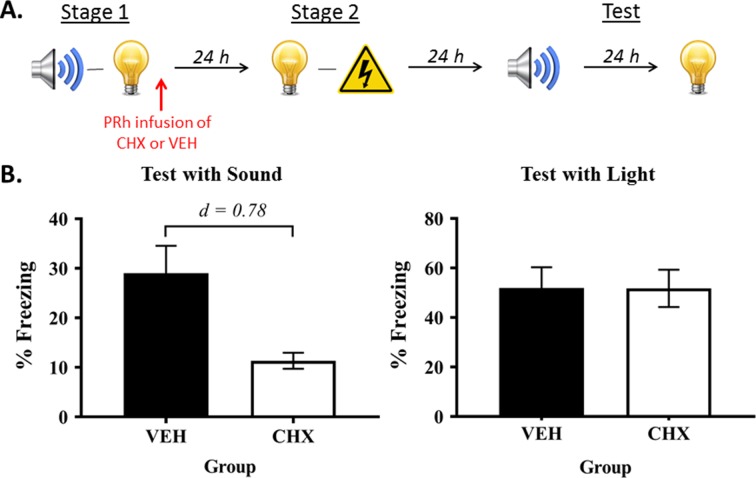
Protein synthesis in the PRh is required for consolidation of a sensory sound-light memory.(A) Schematic of the behavioral procedure for Experiment 2 (Group VEH, n = 8; and Group CHX, n = 10). The red arrow indicates infusions occurred immediately after stage 1 training. (B) Percentage freezing to the preconditioned sound (left panel) and to the conditioned light (right panel), averaged across the eight trials of their respective tests. Data shown are means ± SEM, and Cohen’s d (d) for statistically significant results (contrasts used to compare Group VEH versus Group CHX). For raw data, see the Figure 2—source data 1.10.7554/eLife.47085.005Figure 2—source data 1.Protein synthesis in the PRh is required for consolidation of a sensory sound-light memory.